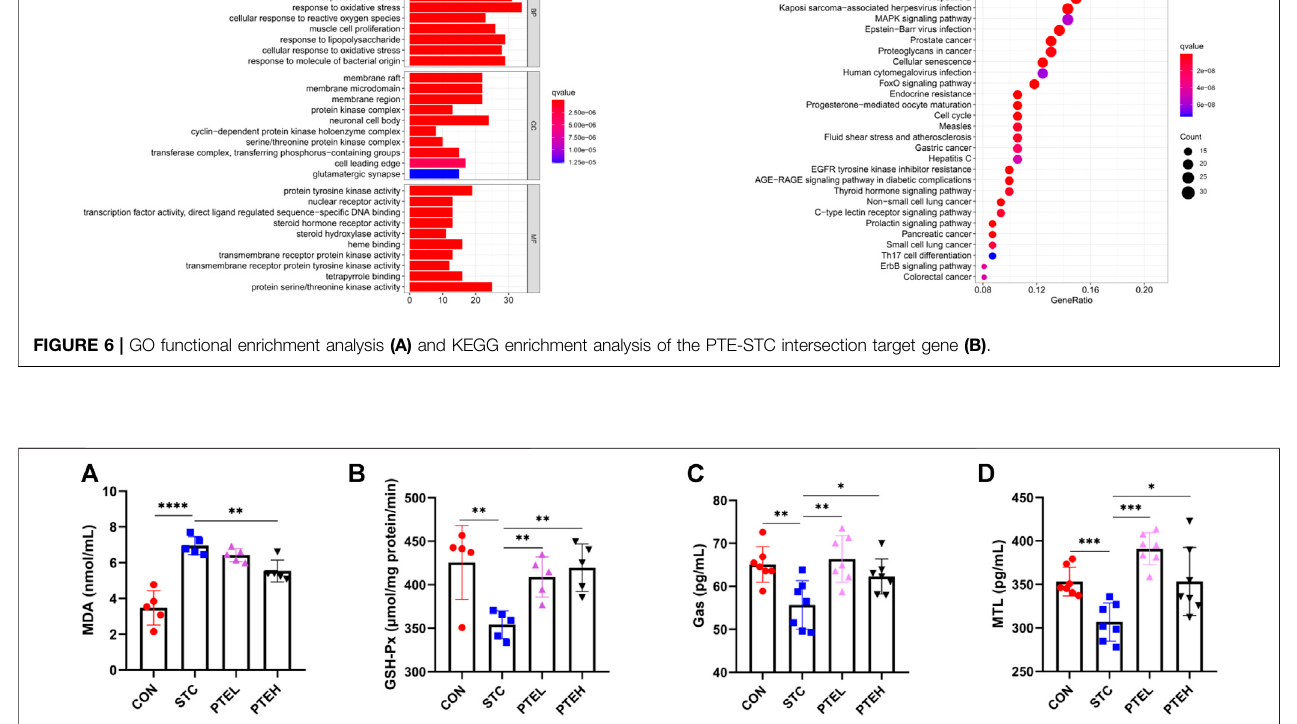
FIGURE 7 | Effects of PTE on oxidative stress-related parameters and gastrointestinal hormones in serum of STC mice. (A,B) The malonaldehyde (MDA) level and GSH-Px were elevated in each group ( n = 5). (C,D) Gas and MTL levels in serum ( n = 7). * p < 0.05, ** p < 0.01, *** p < 0.001 (Gas, Gastrin; MTL, Motilin).